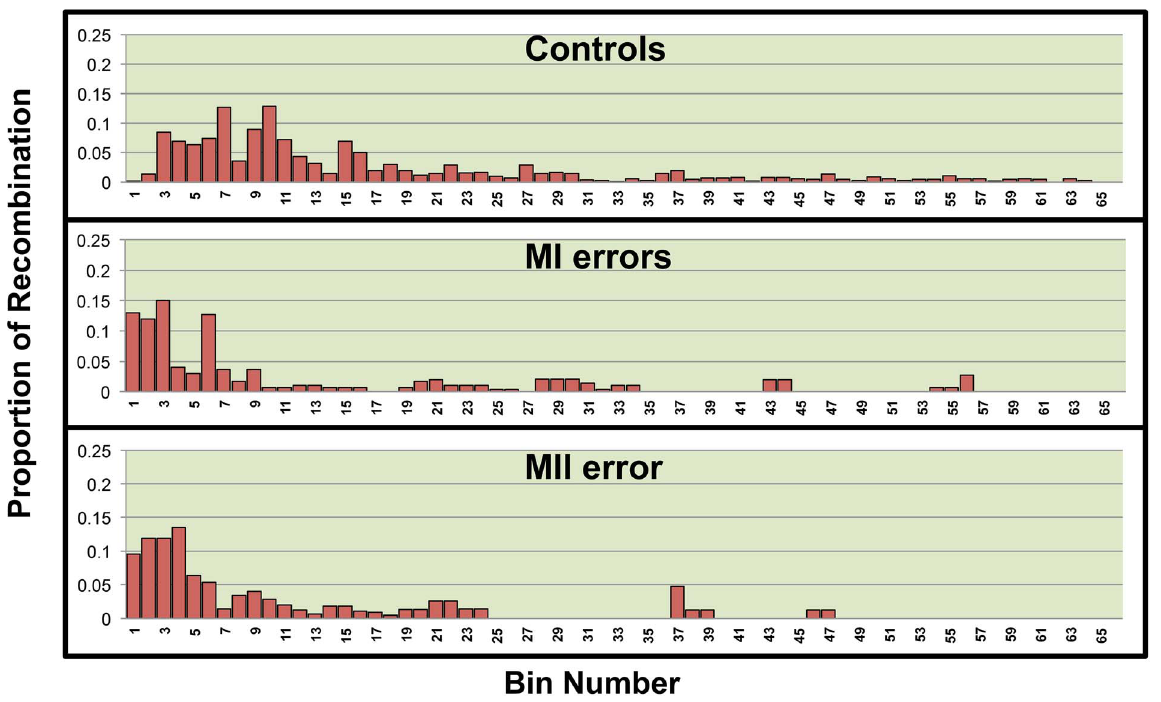
Figure 2. The distribution of the proximal recombinant of a double recombinant event across the long arm of 21q by population. 21q was divided into 66 500 kb bins and the distribution of recombination in each bin from the proximal recombinant event of chromosomes displaying two recombinant events is depicted above.